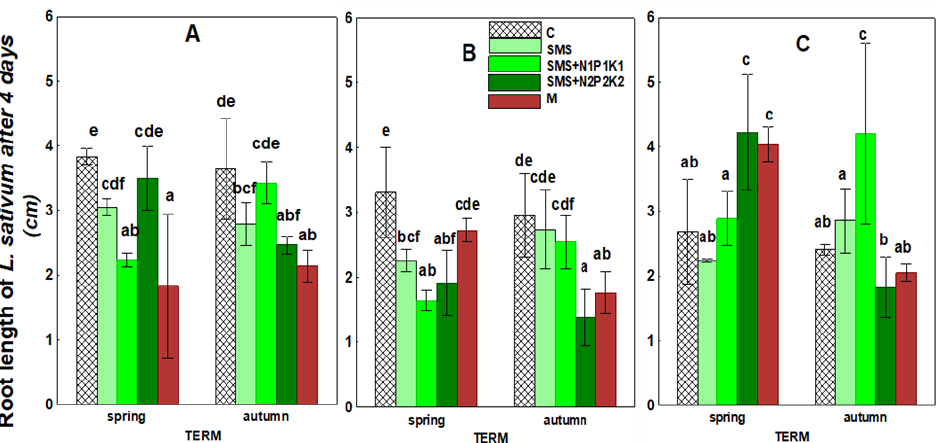
Figure 9. Increase in root length of Lepidium sativum in control soil and soil in different treatment strategies after two days. ( A ) — 1st year; ( B ) — 2nd year; ( C ) — 3rd year. C — control soil; SMS — soil + spent mushroom substrate; SMS + N1P1K1 — soil + spent mushroom substrate + mineral fertiliza- tion N1P1K1; SMS + N2P2K2 — soil + spent mushroom substrate + mineral fertilization N2P2K2; M — soil + manure. The vertical lines indicate the standard deviation. Different letters above the columns indicate significant differences at p < 0.05, and each year was analyzed independent of each other.